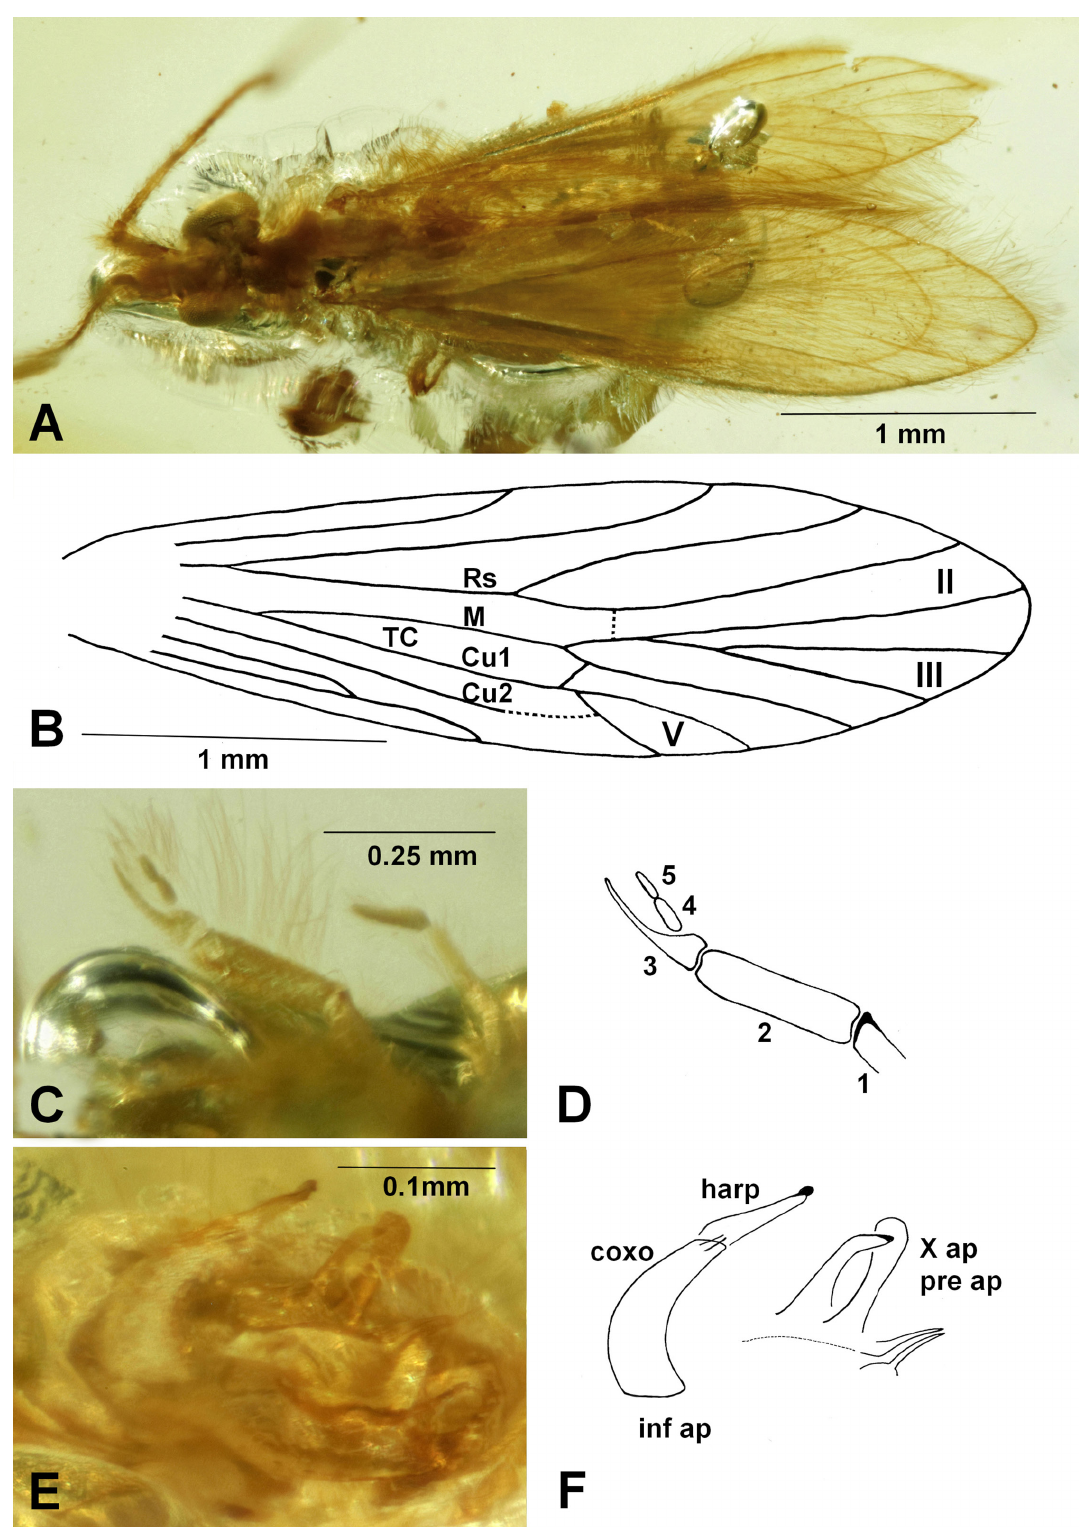
Fig. 3. Cretapsyche kachini sp. nov., holotype, ♂ (ZFMK-TRI000829). A . Dorsal view. B . Drawing of a forewing. C . Maxillary and labial palps. D . Drawing of the maxillary palp. E . Male genitalia in ventrolateral view, distinctly flattened and partially distorted. F . Drawing of male genitalia, left